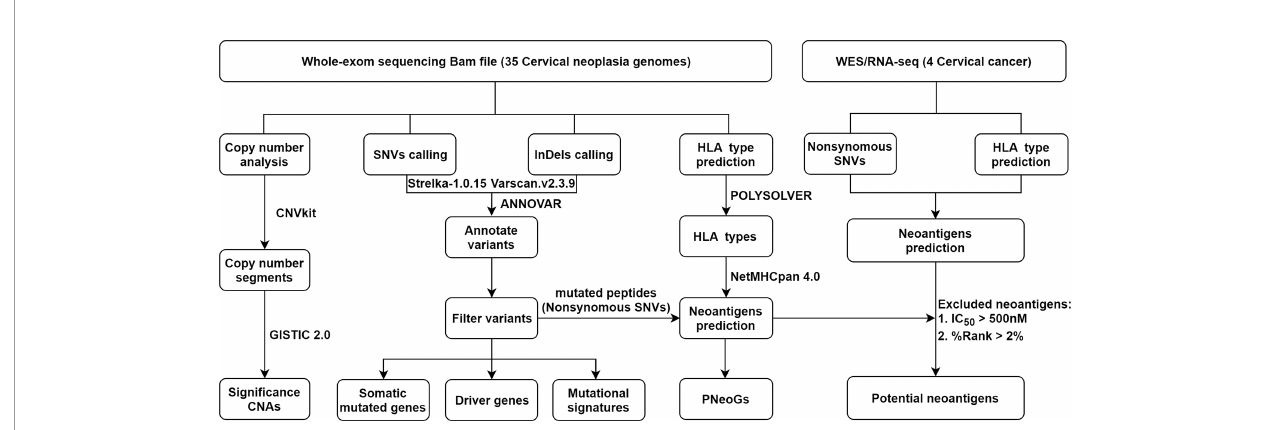
FIGURE 1 | A concise fl owchart of the whole-exome sequencing data